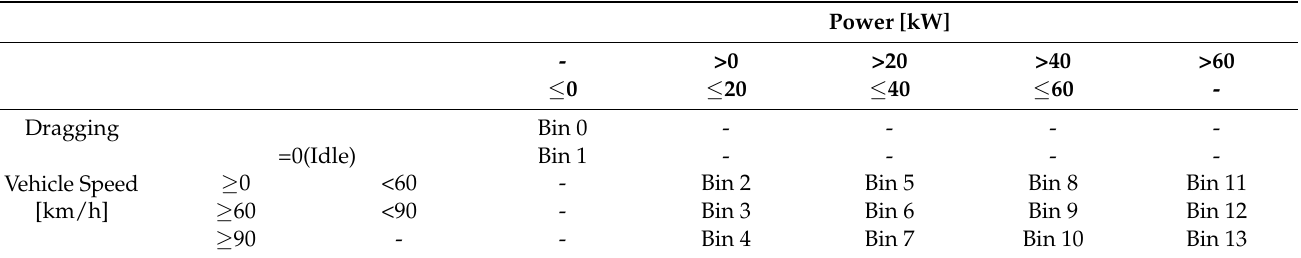
Table 5. Division of the test into different bins depending on vehicle speed and power.